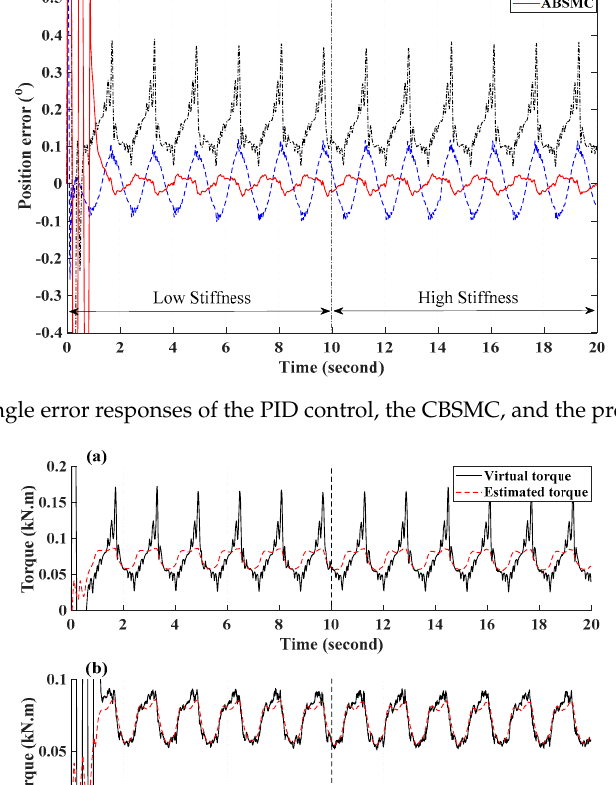
. Figure 10. The control signal of ( a ) the PID control, ( b ) CBSMC, and ( c ) the proposed ABSMC. The error responses of PID, CBSMC, and ABSMC are plotted in Figure 8 with the blue dash line, the black dashed dot line, and the red line, respectively. The results exhibited that the ABSMC with approximators improved the precision of the system more effectively than the PID and CBSMC. Figure 9 shows the torque responses of the CBSMC and the ABSMC, with a virtual torque shown as the black line and estimated torque shown as the dashed red line. The results also show that the proposed control improved the tracking torque error by using the approximation to compensate for the uncertainties in hydraulic dynamics. Figure 10 plots the control signals of the PID control, BSMC, and ABSMC. Furthermore, the responses of weights in the approximators are presented in Figure 11. The results verified the convergence of weights of the approximators.